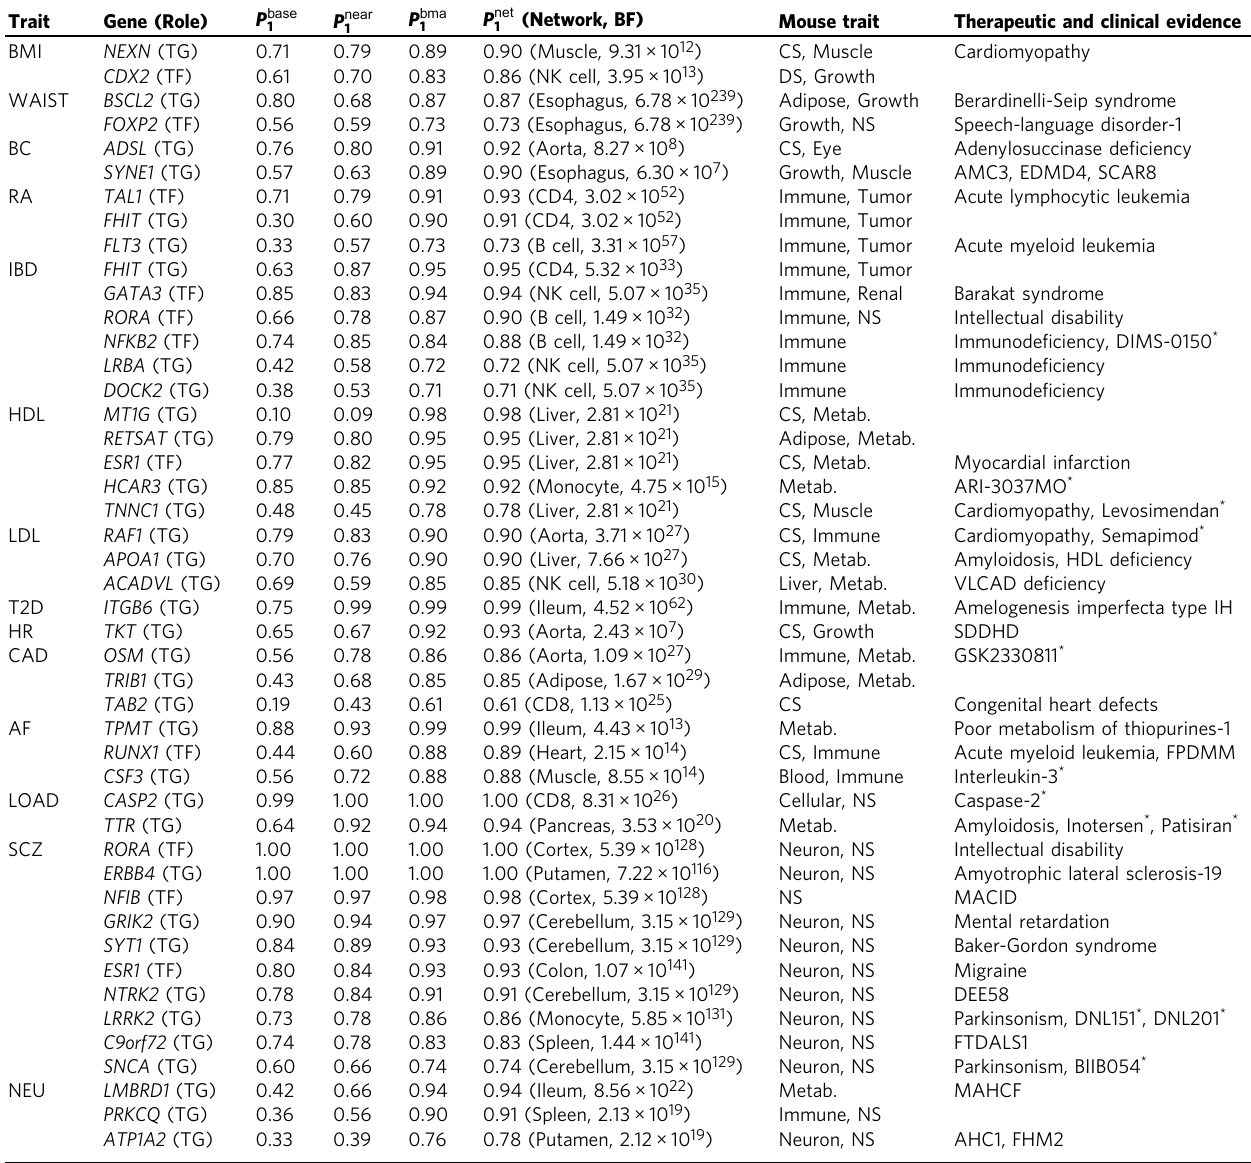
Table 2 Examples of RSS-NET highlighted genes that have not reached genome-wide signi fi cance in the GWAS Catalog 1 at the time of